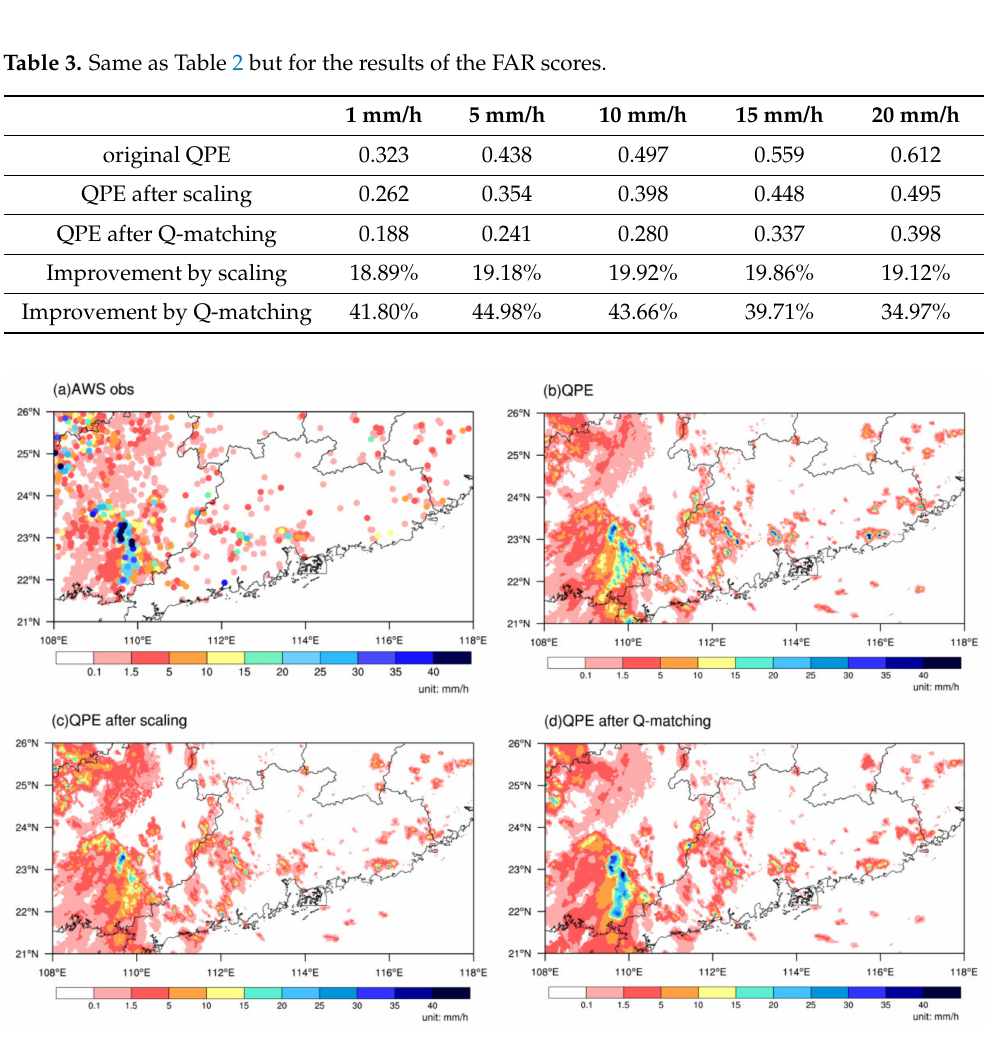
Figure 8. Precipitation case study on 07 UTC 20 August 2020. ( a ) AWS observational rainfall. ( b ) The original radar QPE products. ( c ) QPE after correction by scaling. ( d ) QPE after correction by Q-matching. Unit is